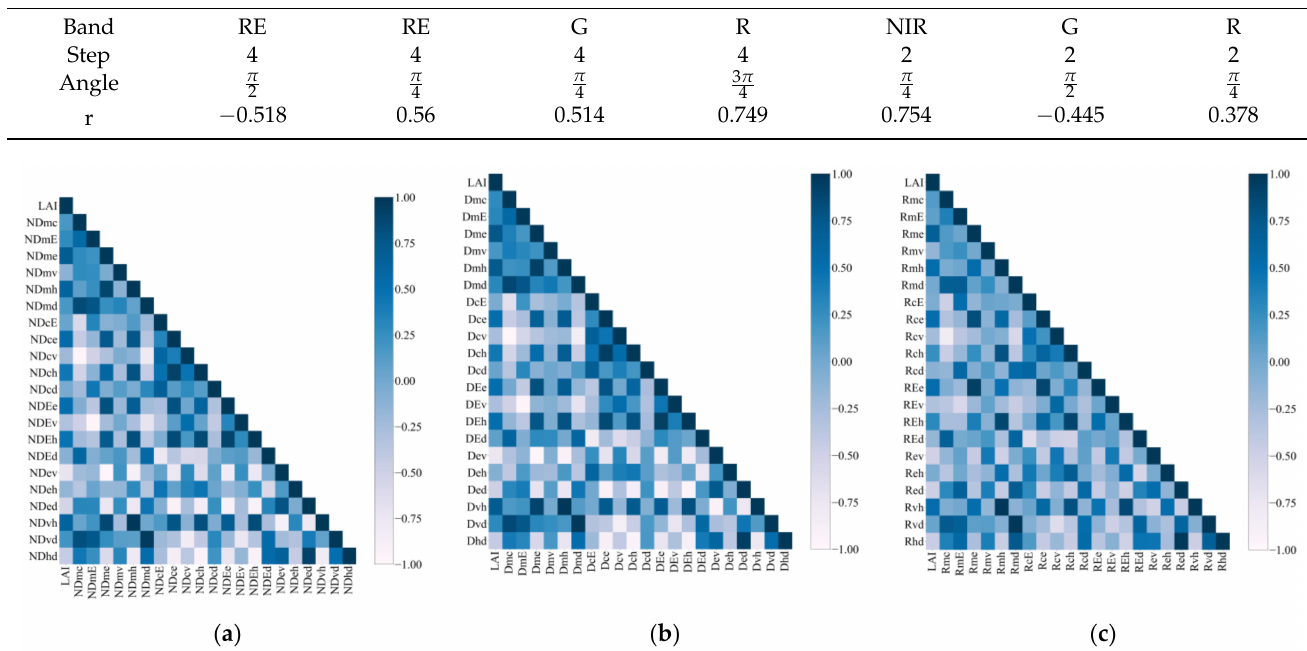
Figure 3. The results of correlation analysis of maize LAI and texture feature indices: ( a ) NDTIs; ( b ) DTIs; and ( c )